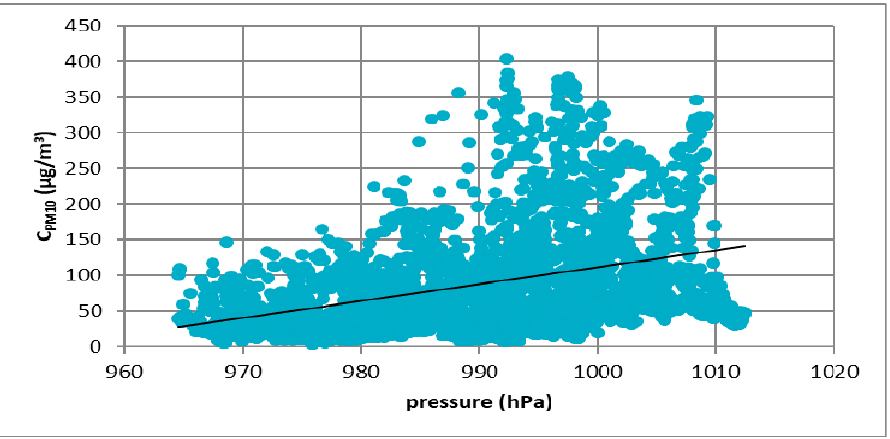
Figure 8. The effect of atmospheric pressure on PM10 concentration in Kraków in 2017. Figure 8. The e ff ect of atmospheric pressure on PM10 concentration in Krak ó w in 2017.